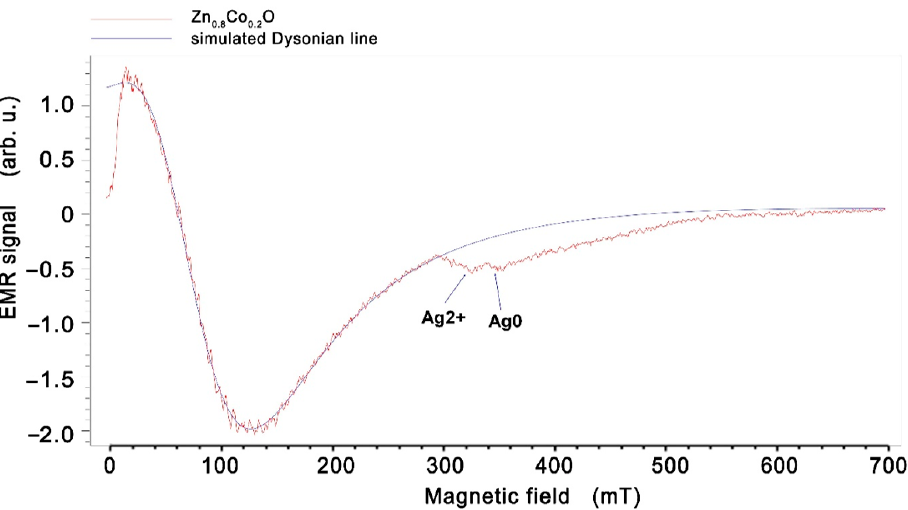
Figure 4. EMR spectra of Zn 0.8 Co 0.2 O embedded with Ag NPs film obtained at temperature 300 K with the simulated Dyson-type line. Small intensity lines from Ag 2+ and Ag 0 are described.